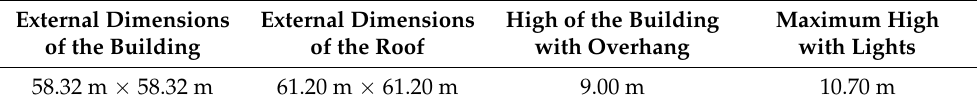
Table 1. External dimensions of the main